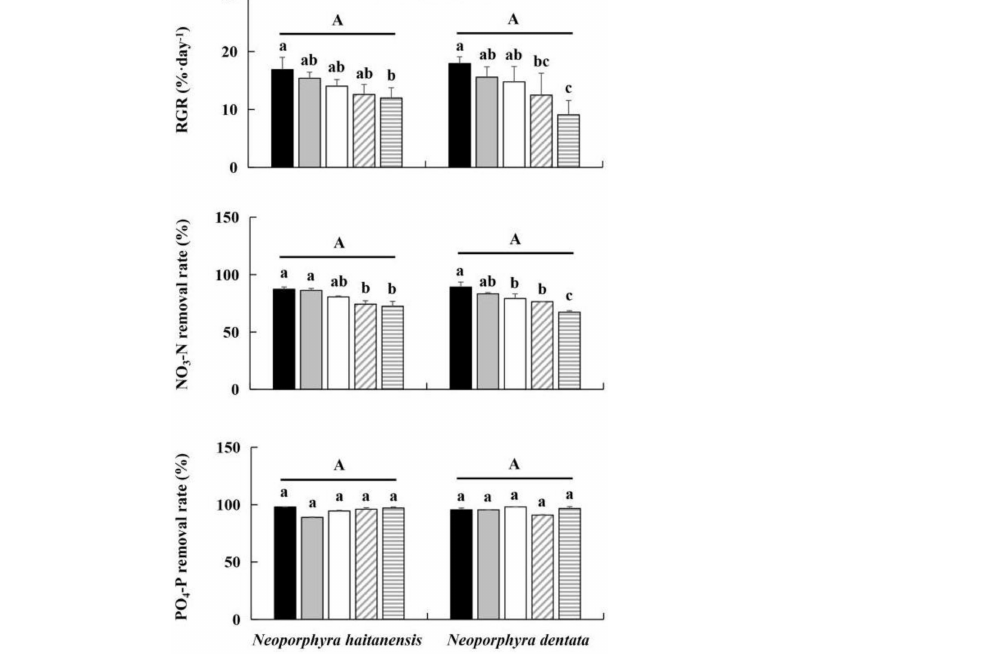
Figure 1. The RGRs and NO 3 -N and PO 4 -P removal rates of N. haitanensis and N. dentata cultured for 4 days under five desiccation periods. Different capital and small letters indicate statistical significance ( P < 0.05) among species and desiccation periods, respectively. The data represent the mean ± SE (n = 3